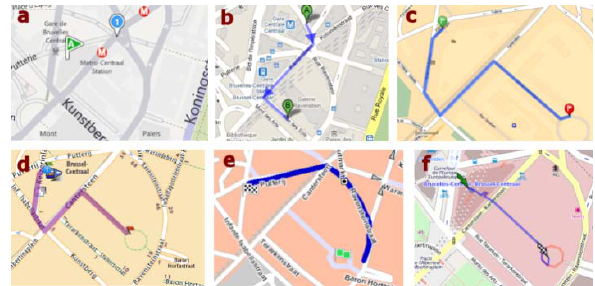
Figure 35: Brussels Central Station to Ravensteingallerij using route planner (a) Bing ,(b) Google Maps, (c) Mappy, (d) Via Michelin, (e) RouteNet and (f) OpenRouteService. From Vanclooster et al (2012).